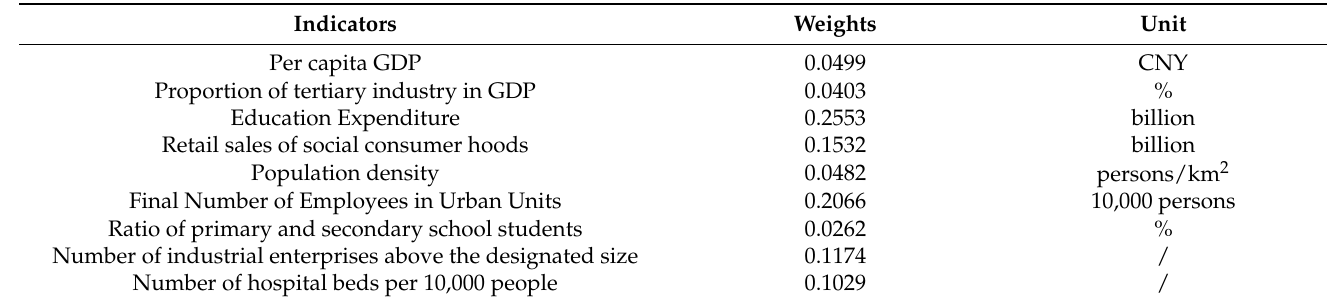
Table 1. Indicators and weights of the economic–social system